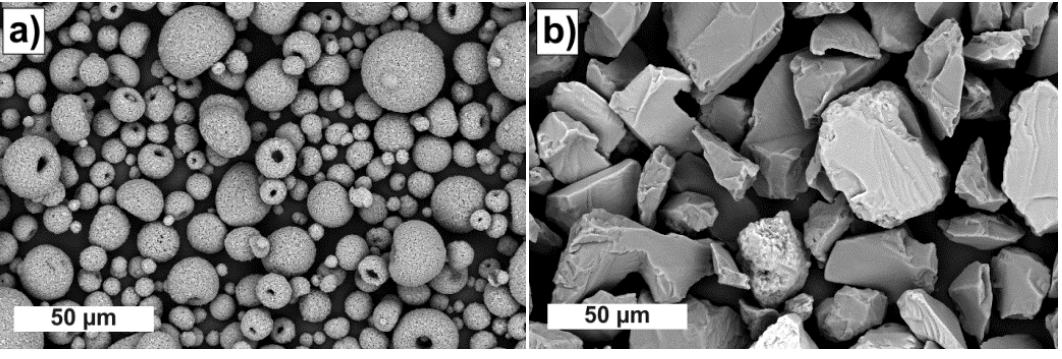
Figure 1. Powder morphologies of ( a ) agglomerated and sintered Al (Neoxid A103, HVOF cut) and ( b ) fused and crushed Al APS cut). SEM